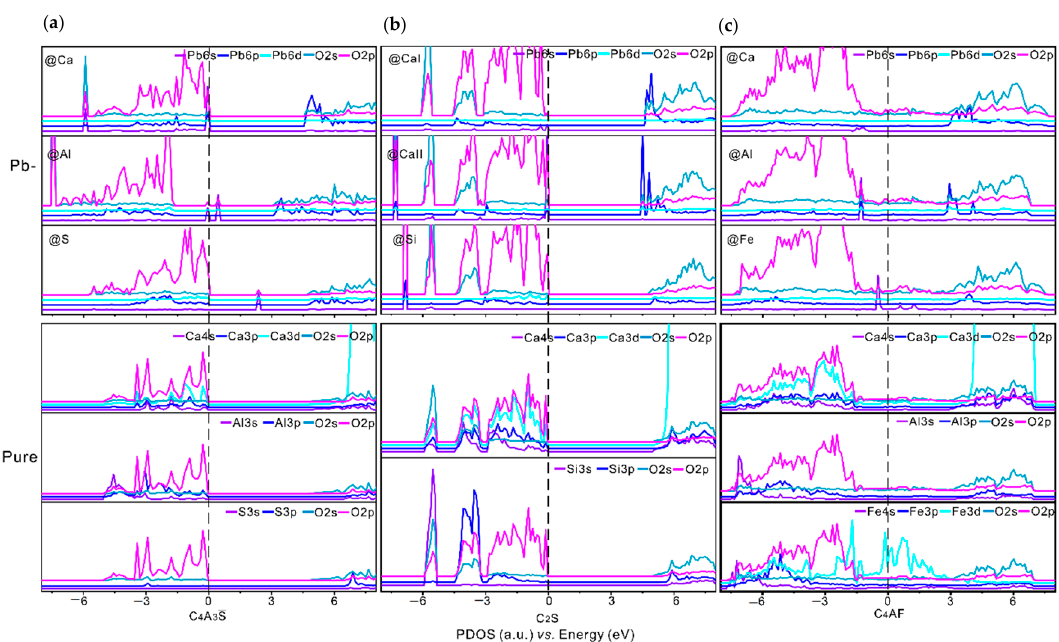
Figure 5. The partial density of states (PDOS) of pure and Pb-doped SAC clinker Phases: ( a ) C 4 A 3 S(cid:3364) , ( b ) C 2 S, and ( c ) C 4 AF. The Fermi energy was set to zero eV.